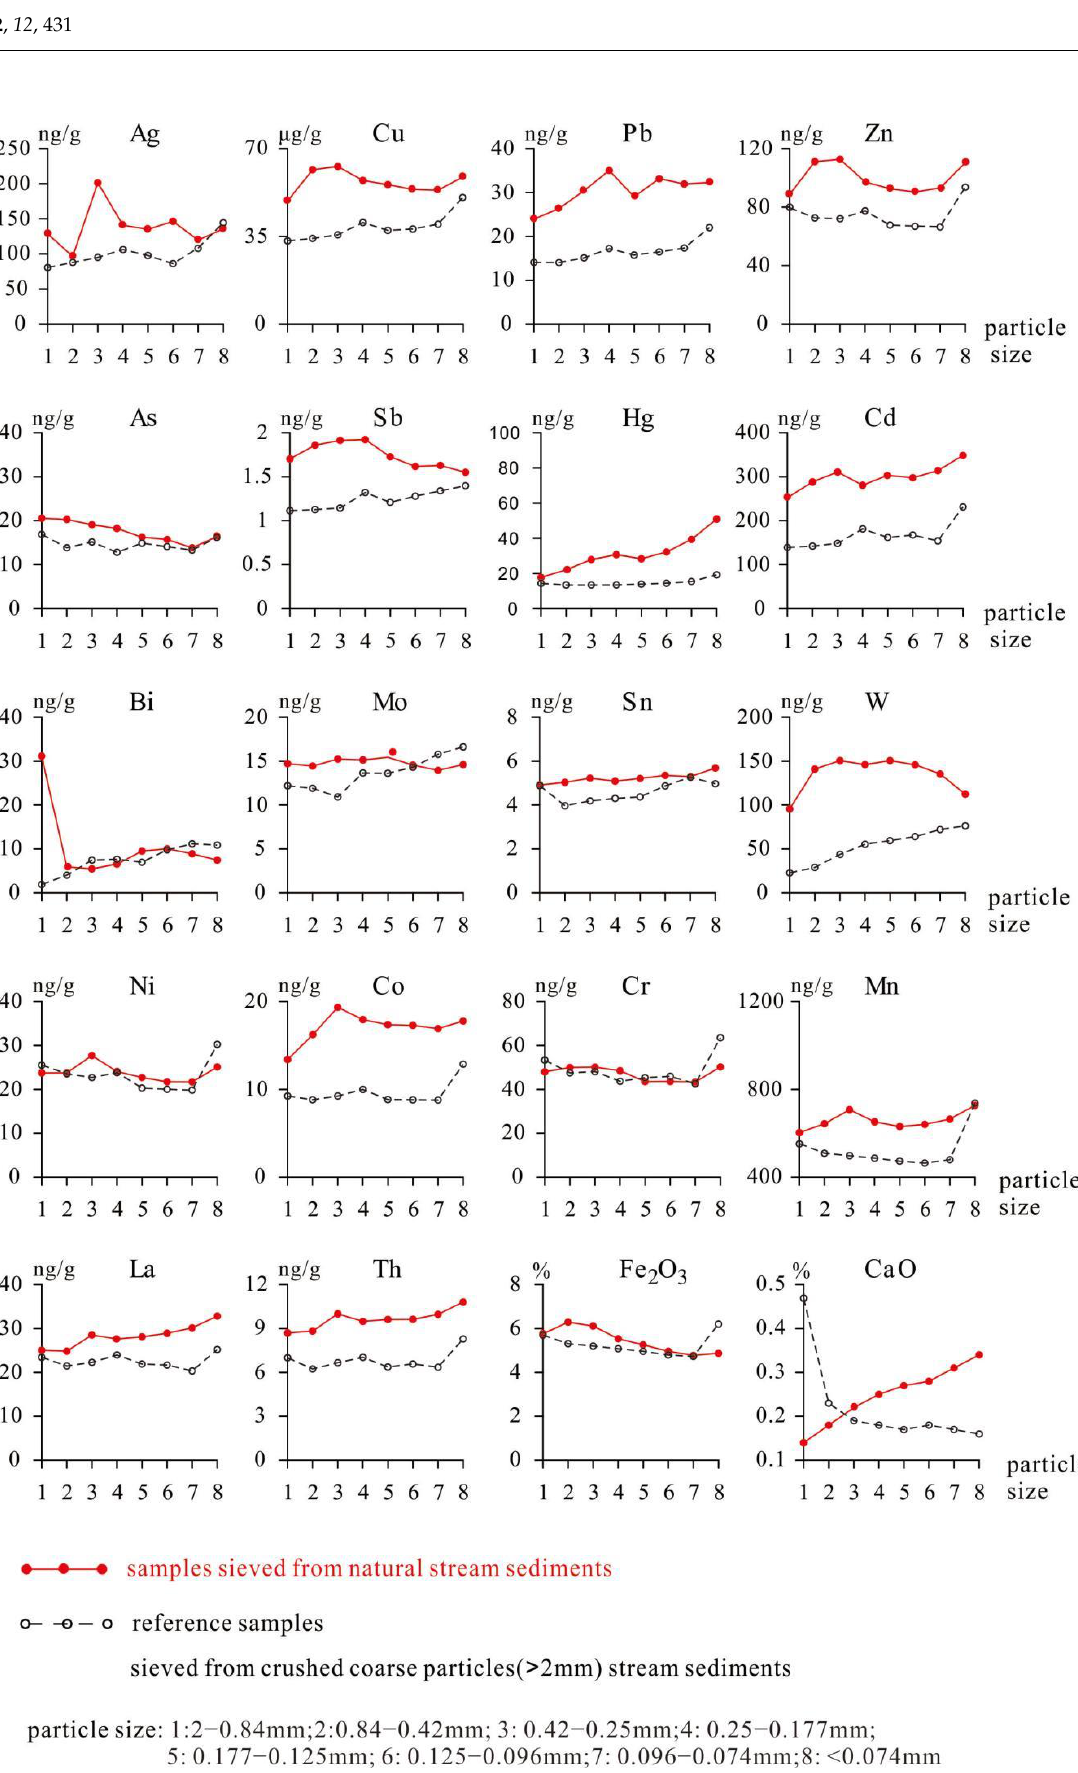
Figure 4. Element distributions in different particle size fractions of stream sediments (JSL2).